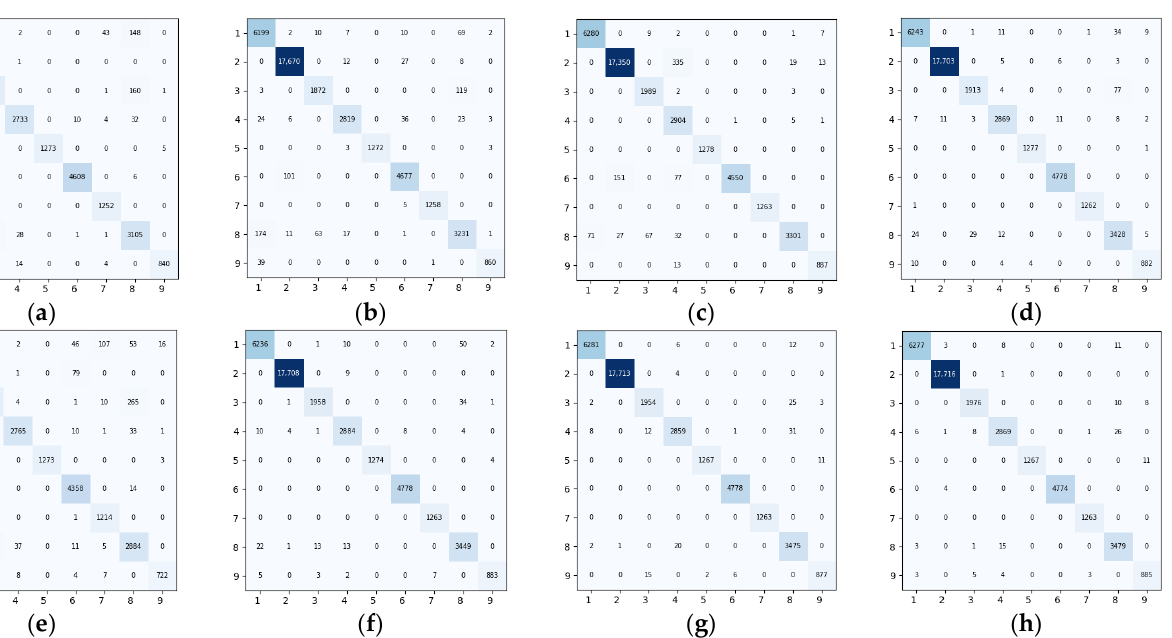
Figure 12. Confusion matrix of different methods for the University of Pavia data set. ( a ) Baseline